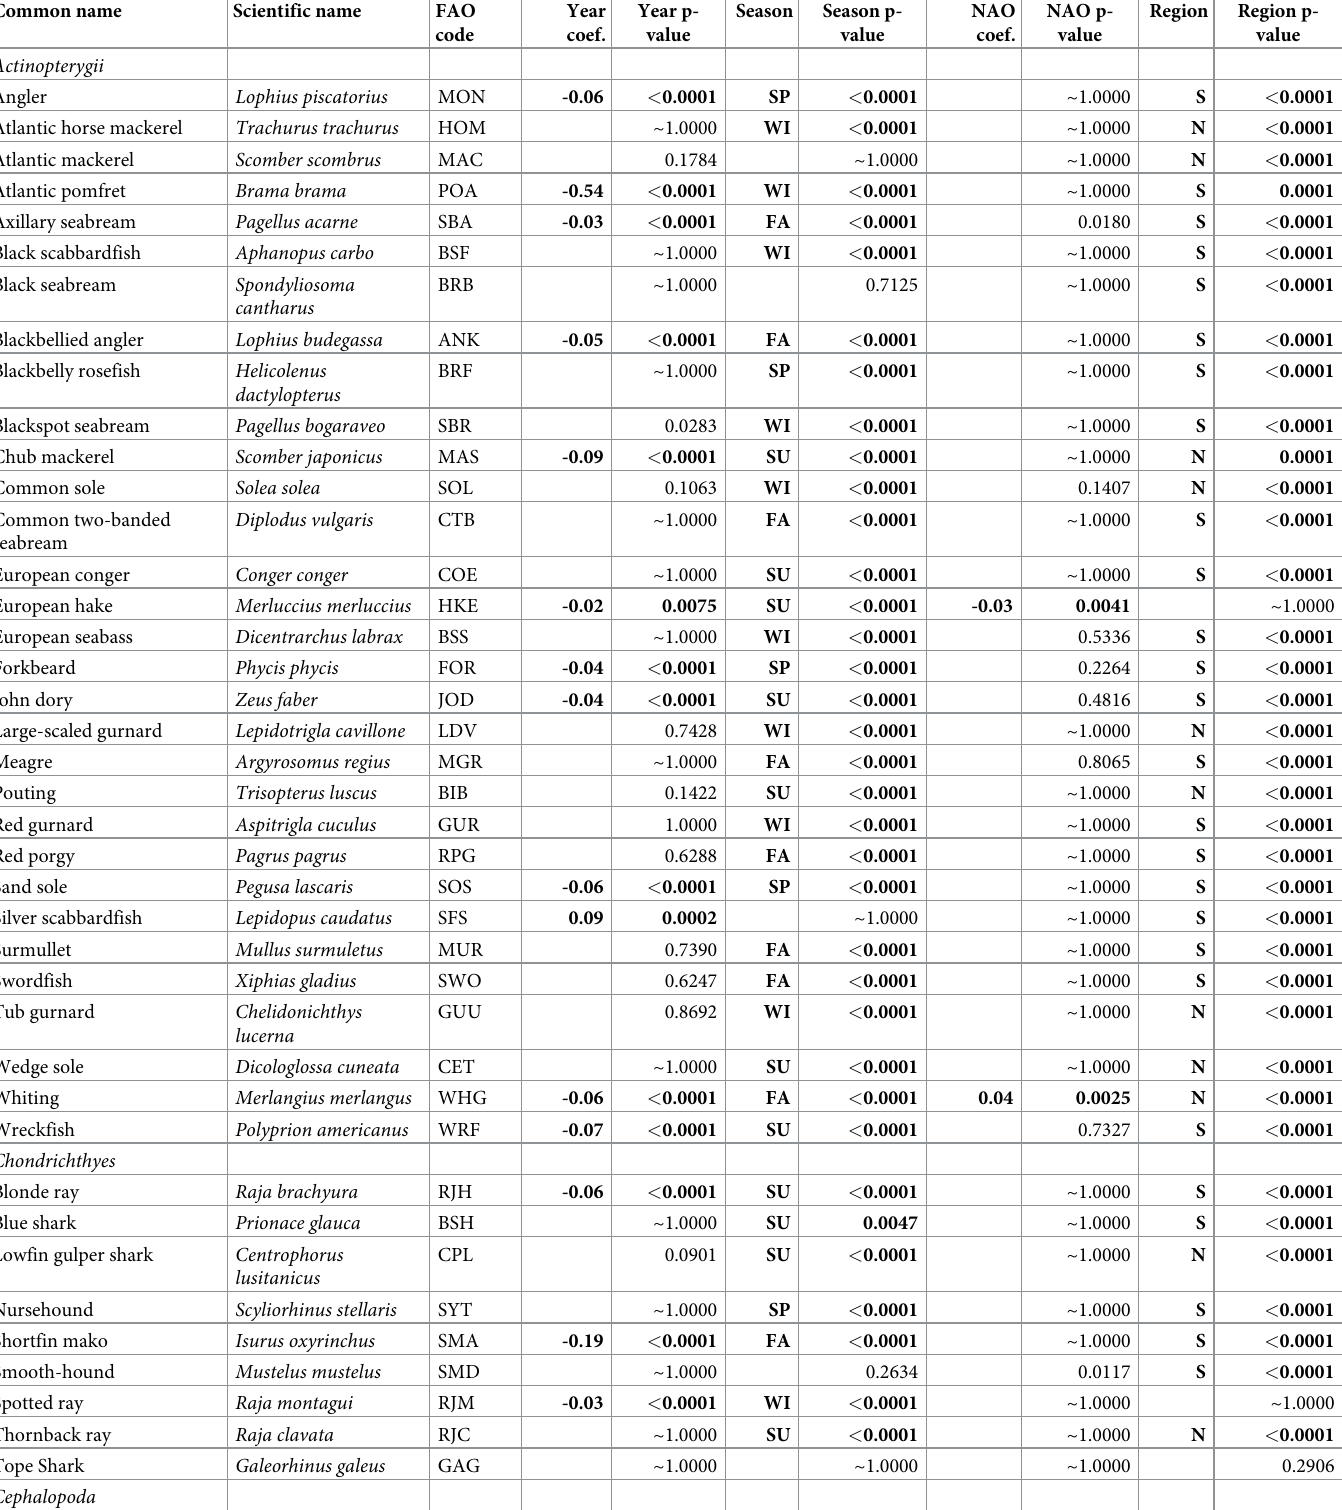
Table 1. Results of linear model for each of the 48 species